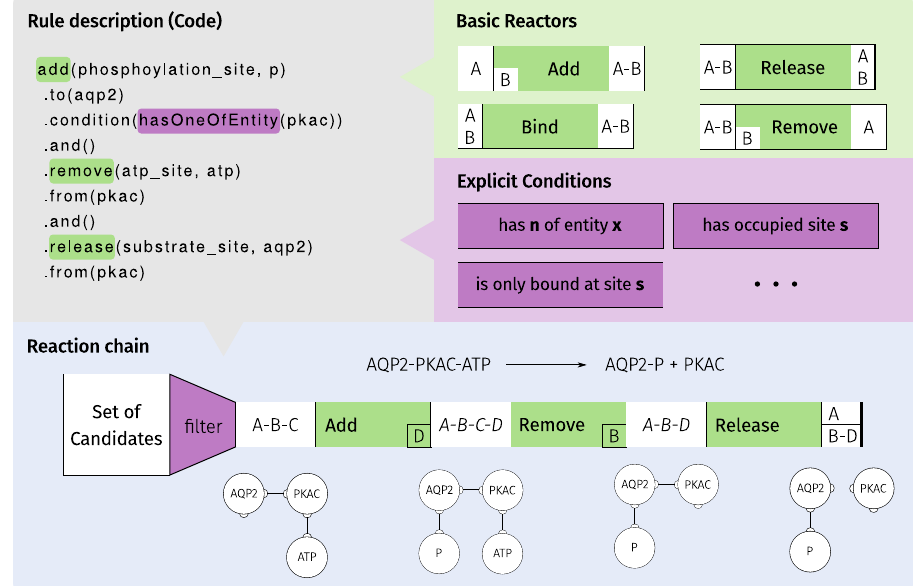
Fig. 8 De fi nition of reaction rules. Reactions can be speci fi ed by a description of the reaction process. Basic reactors are concatenated to chains that are processed during the reaction network generation. Additionally, conditions allow for further speci fi cation of the reaction process. The network generation process results in all reactions that can occur in the